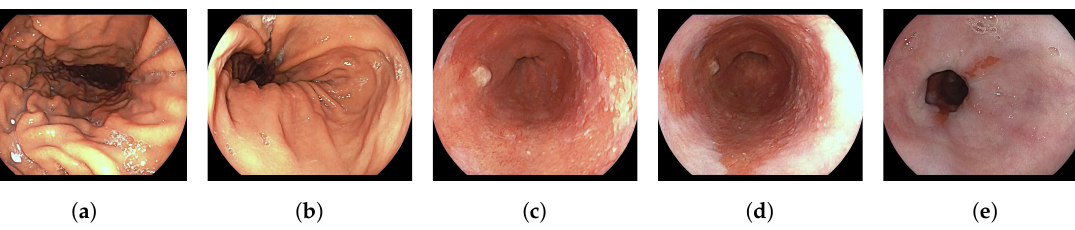
Figure 1. Visual examples for each tissue label to be classified by the model sourced from pullback videos. These pullback videos start recording from the ( a ) Stomach and stops, while pulling the endoscope with a constant speed, at the ( e ) Squamous area. ( a ) Stomach; ( b ) Transition-zone Z-line; ( c ) Barrett; ( d ) Transition-zone Squamous; ( e ) Squamous.